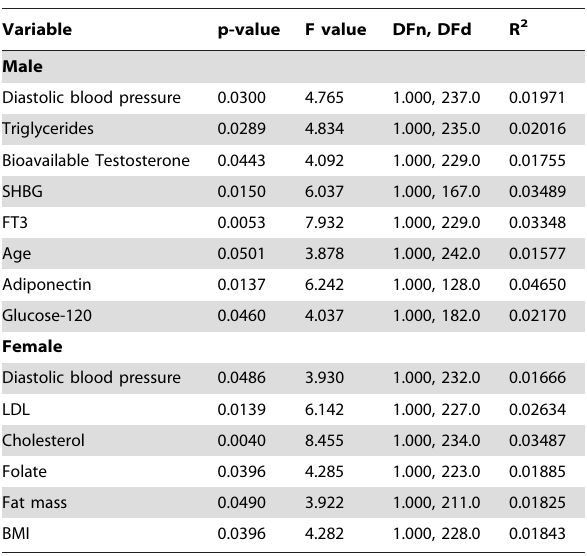
Table 2. Linear Regression analysis of plasma BDNF and metabolic and cardiovascular dysfunction risk factors, measured in males and females in the BLSA